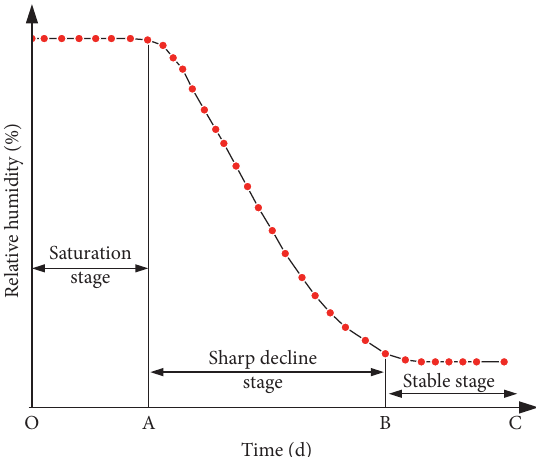
Figure 7: Stages of the internal relative humidity evolution of CPB with